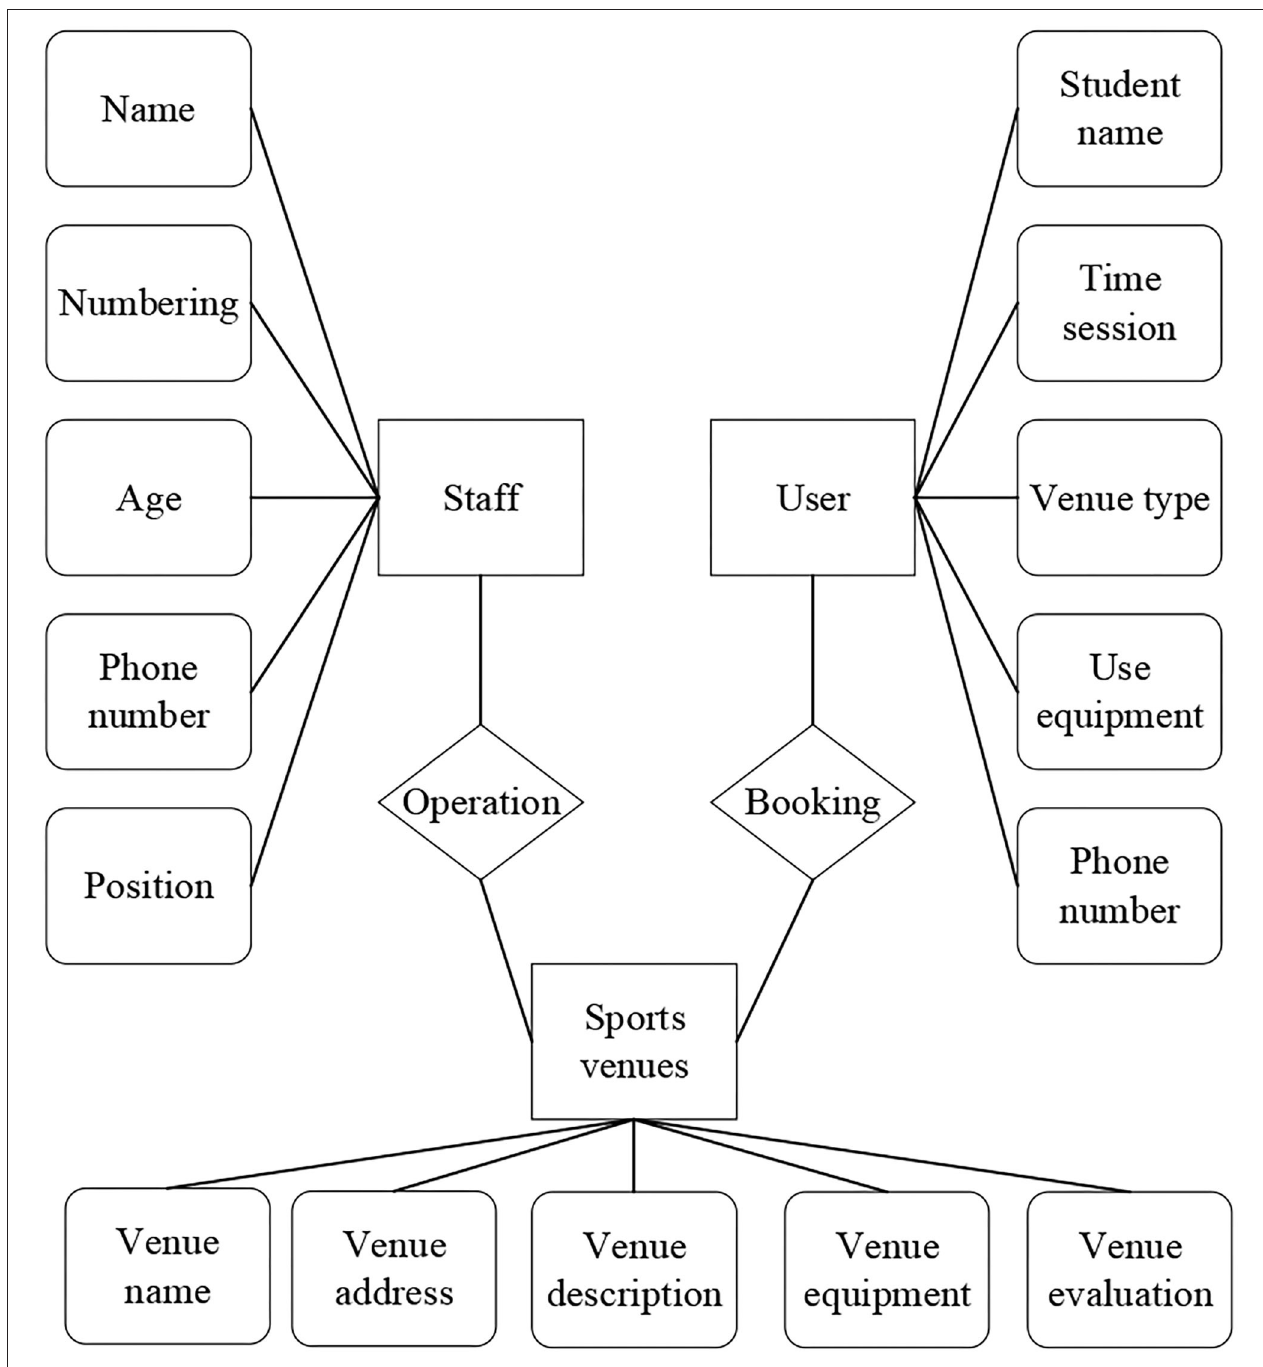
FIGURE 4 | E-R diagram of venue